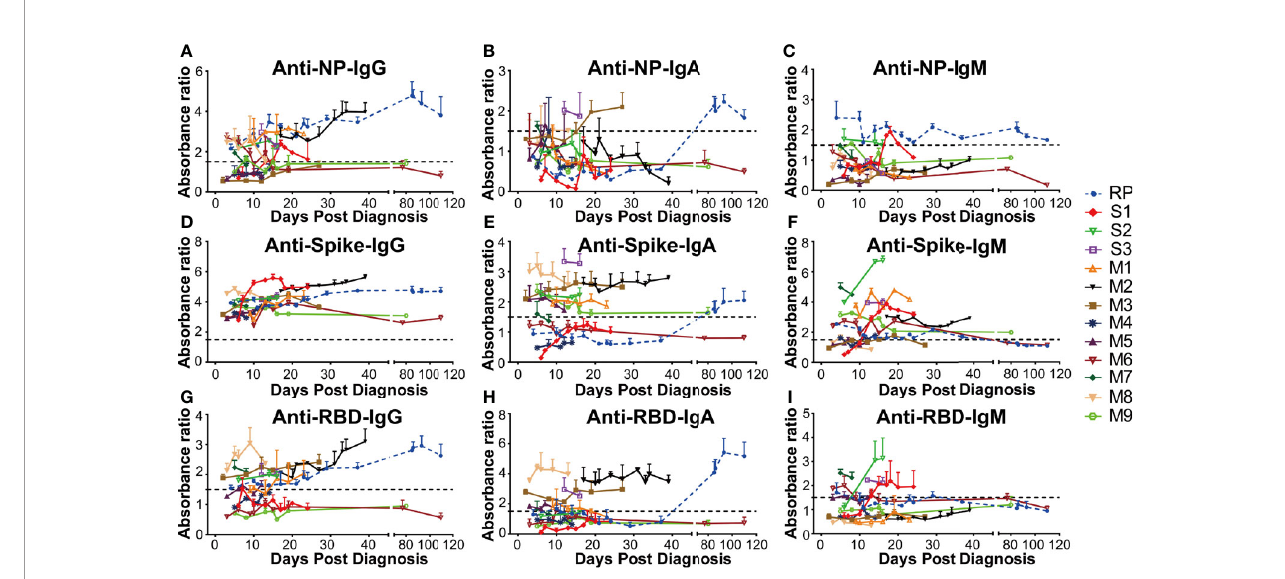
FIGURE 3 | The dynamic change of anti-SARS-CoV-2 antibody in all COVID-19 patients. The absorbance ratio was calculated by the absorbance value of COVID-19 patients divided by 2.1 × mean absorbance value offour SARS-CoV-2 RNA negative plasma pool samples. (A) Anti-nucleocapsid (NP) IgG; (B) Anti-NP IgA; (C) Anti-NP IgM; (D) Anti-spike IgG; (E) Anti-spike IgA; (F) Anti-spike IgM; (G) Anti-receptor-binding domain (RBD) IgG; (H) Anti-RBD IgA; (I) Anti-RBD IgM. RP, re-tested positivity; M, Mild-to- moderate; S,